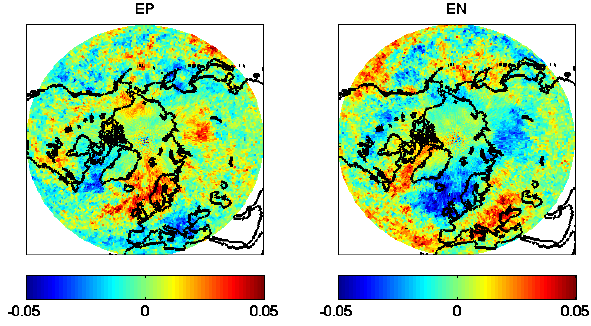
Fig. 9. Cloud fraction anomalies derived using AIRS data at 400hPa for the EP and EN cases show a 2-D manifestation of the Greenland Fig. 9: Cloud fraction anomalies derived using AIRS data at 400 hPa for the EP and EN Cloud Dipole Anomaly (GCDA) in the middle troposphere. cases show a 2D manifestation of the Greenland Cloud Dipole Anomaly (GCDA) in the middle troposphere.